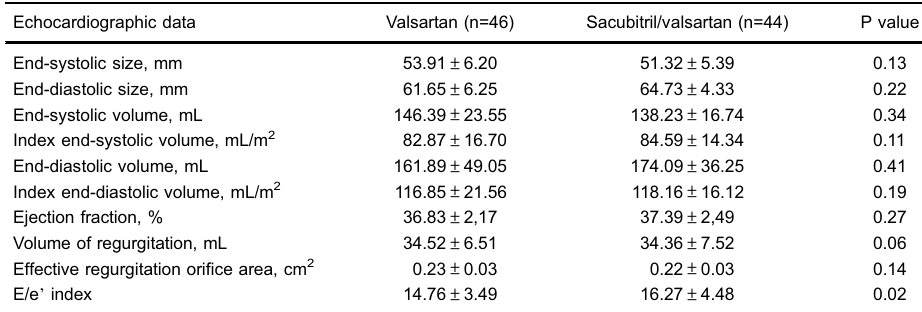
Table 3. Echocardiographic data of patients included in the study according to treatment. Echocardiographic data